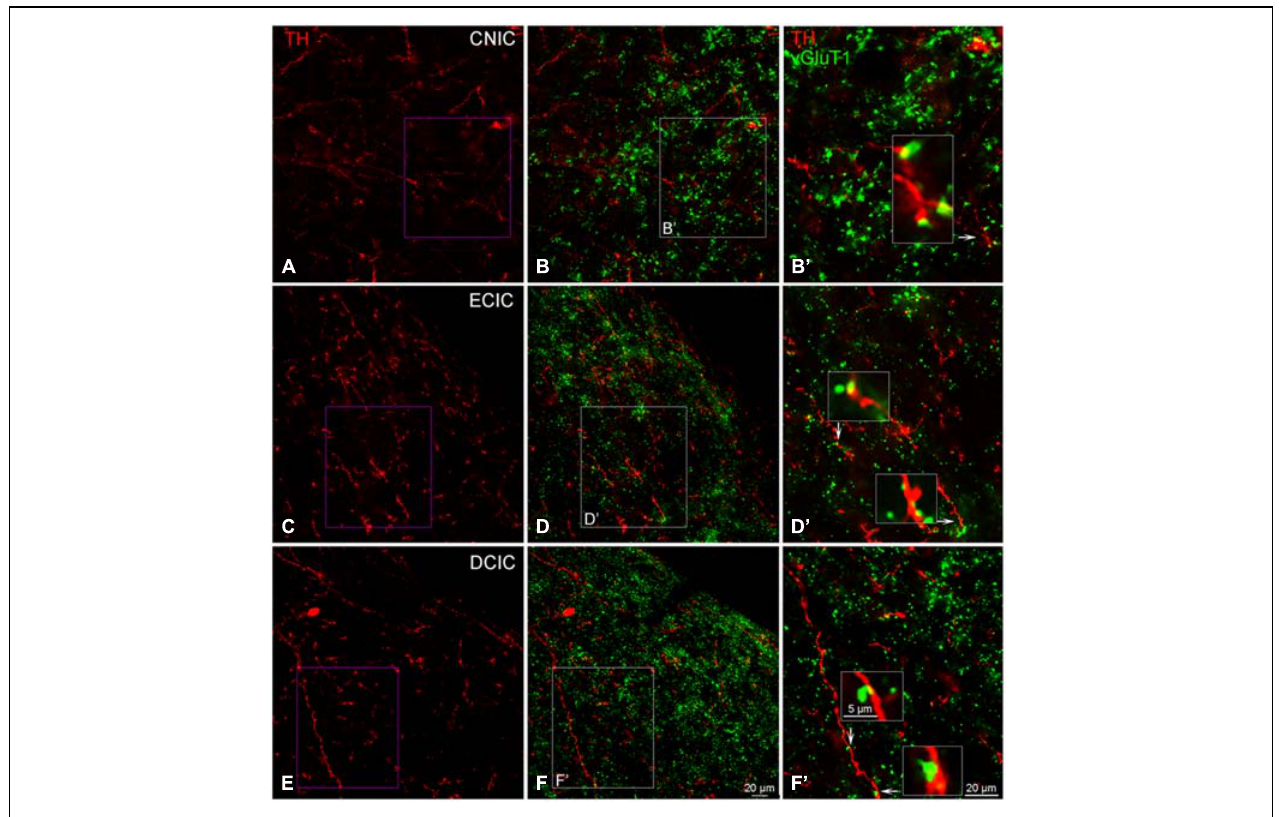
FIGURE 13 | In the IC VGLUT1 (green) is distributed throughout each subdivision and is closely associated with TH labeled (red) terminals. Terminals labeled for TH in the CNIC, ECIC, and DCIC (A,C,E) appear to be in close contact with VGLUT1 labeled terminals